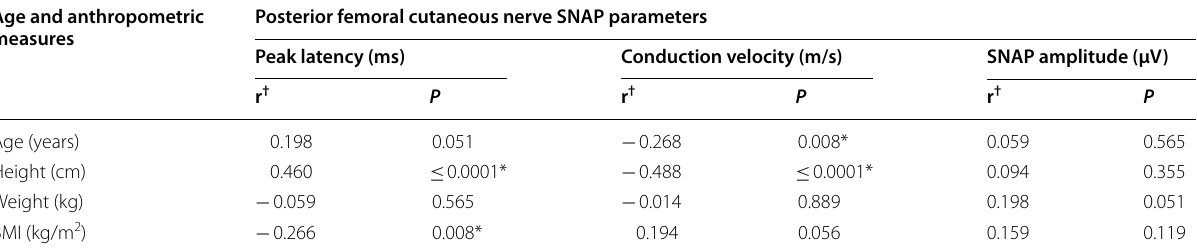
Table 7 Correlation between volunteers’ age and anthropometric measures with different posterior femoral cutaneous nerve sensory nerve action potential parameters (98 lower limbs from 52 apparently healthy volunteers)